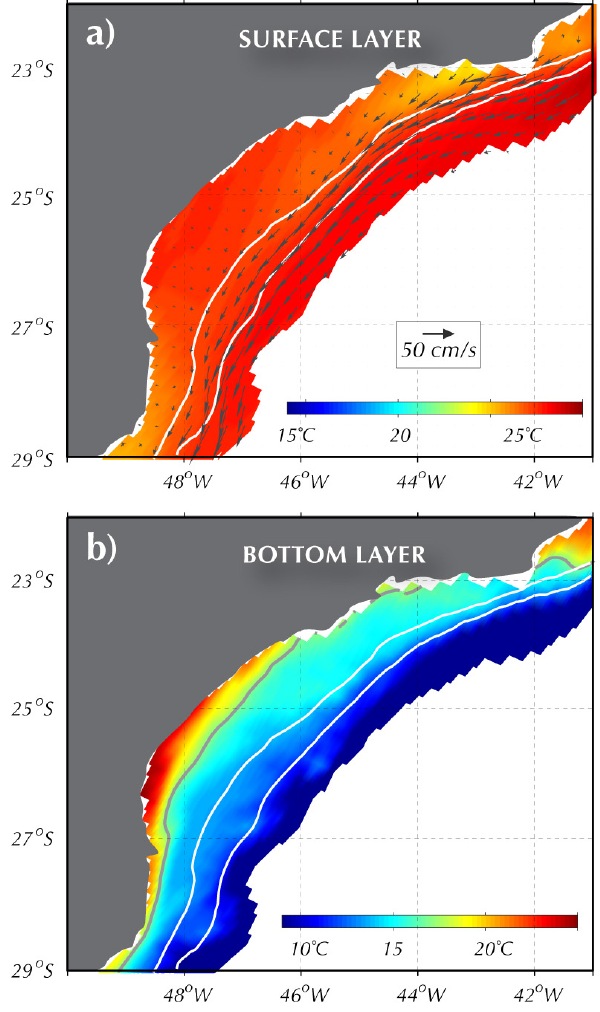
Fig. 4. EXP2: (a) Summer sea surface temperature and surface velocity vectors and (b) Bottom temperature. White contours mark the 100 and 200 isobaths. The black line in panel (b) is the 17 ◦ C isotherm, indicative of the SACW penetration. Note that each panel uses a different color